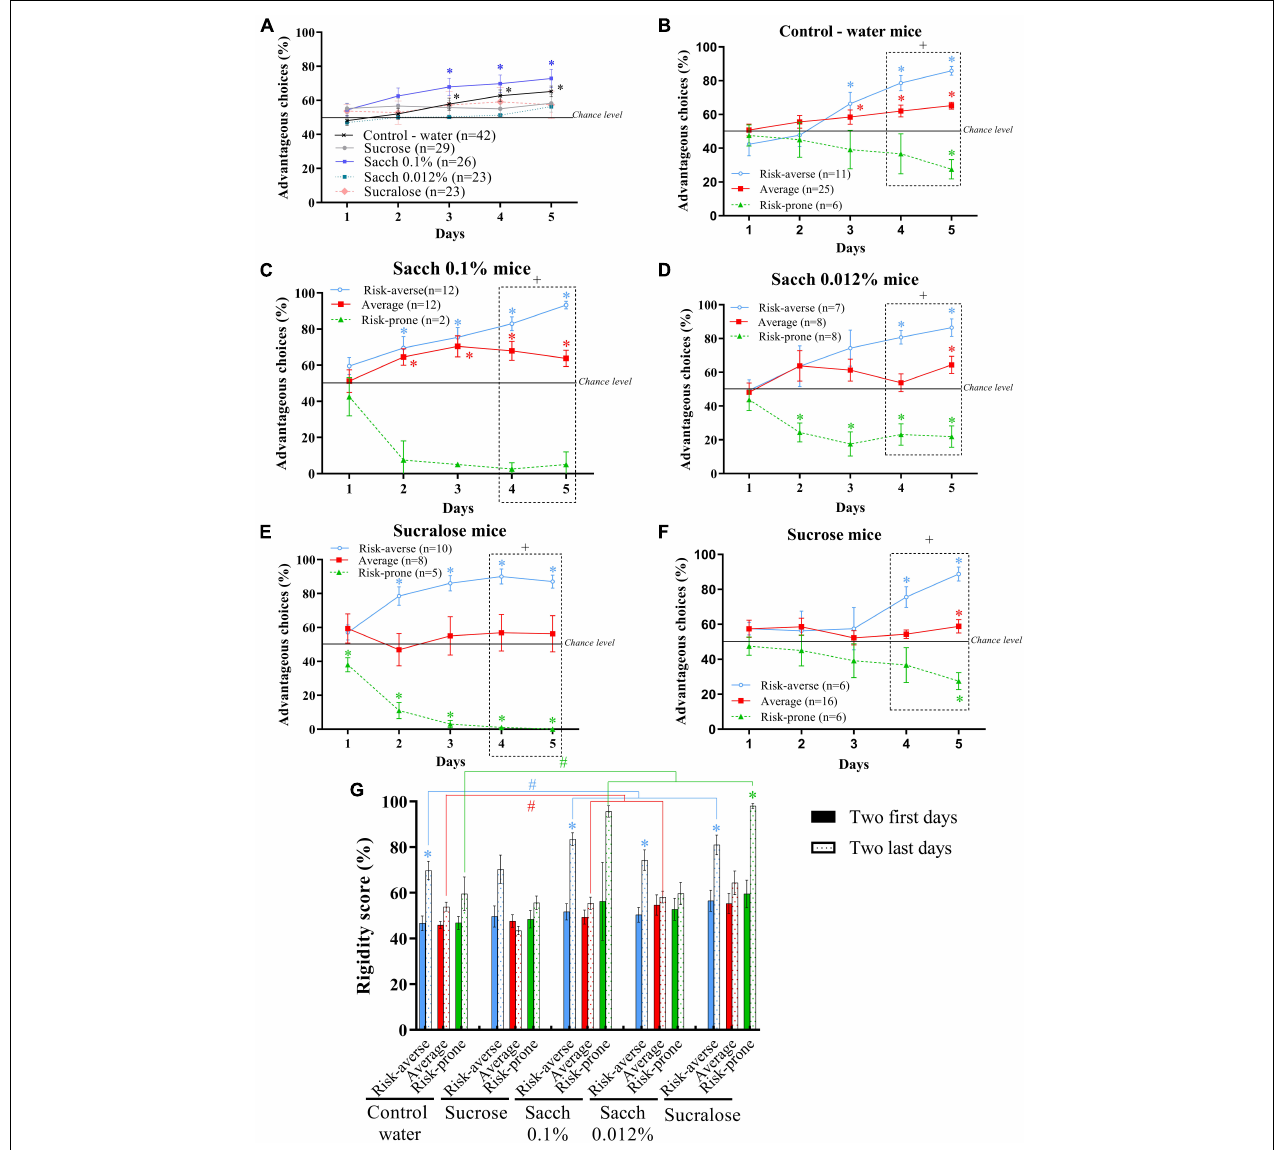
FIGURE 6 | (A) Evolution of preferences of animals as a group during the MGT for mice drinking water, sucrose, Saccharin 0.1%, Saccharin 0.012% or sucralose. ∗ p < 0.05 from chance level. (B–F) Evolution of preferences of subgroups of animals (risk-averse, average and risk-prone) from days 1 through 5 in the MGT for mice drinking water (B) , sucrose (C) , Saccharin 0.1% (D) , Saccharin 0.012% (E) or sucralose (F) . ∗ p < 0.05 from chance level. + p < 0.05 differences between the three groups (Kruskal Wallis). (G) Rigidity scores of risk-averse, average and risk-prone mice at the beginning and the end of the MGT. ∗ p < 0.05 difference between the first and last 2 days. # p < 0.05 difference between drinking groups. Adapted from Hamelin et al.,